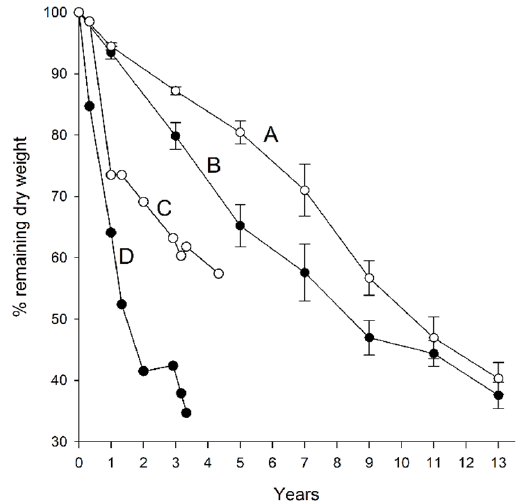
Figure 2. Dry weight loss of spruce cones during 13 years (A–B) and spruce needles during 3–5 years (C–D). It is distinguished between moss-covered forest floor (filled circles) and vegetation-free needle mats below trees (open circles). Vertical bars show standard error (SE). Modified from [16].